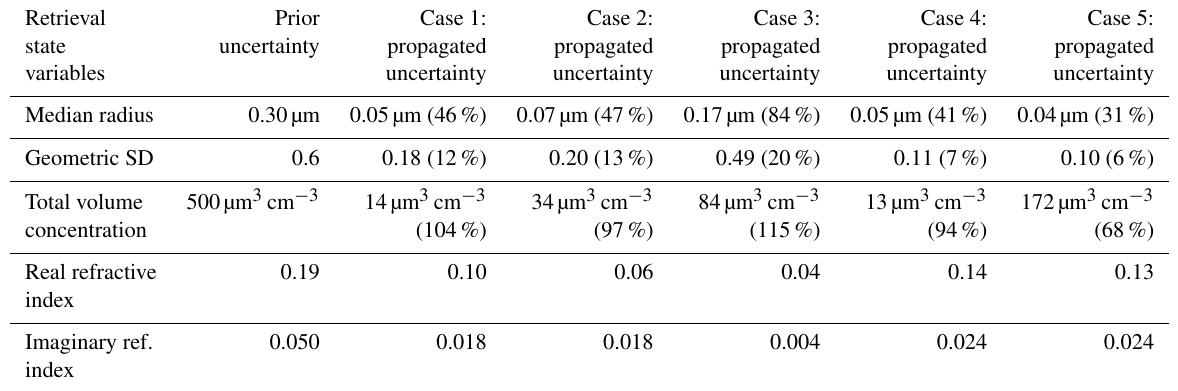
Table 7. Like Table 3, but using total volume concentration instead of total number concentration as a state variable, this table shows propagated uncertainties (standard deviations) for state variables and selected additional variables derived from the state variables, shown for the reference cases described in Table 1. The propagated uncertainties (Eq. 9), depend on assumed measurement errors of 5% for backscatter and 20% for extinction and depend on a priori covariance as described in the text. The assumed a priori uncertainties are listed for